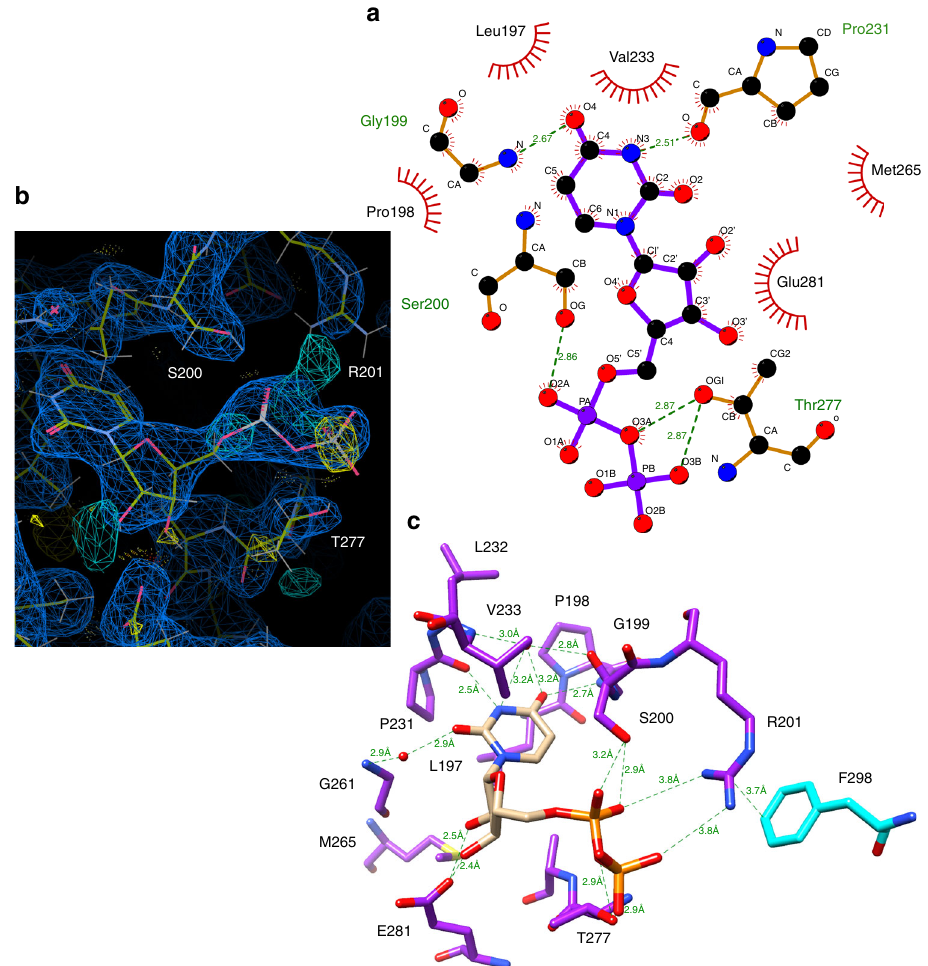
Fig. 3 LpxB nucleotide-binding pocket. The uracil of UDP binds in a hydrophobic pocket formed by L197, P198, P231, and V233. Putative hydrogen-bond distances in angstroms are as follows: G199 N to uracil O4 (2.7), G199 O to water to uracil O4 (2.8, 3.2), V233 N to water to uracil O4 (3.0, 3.2), P231 O to uracil N3 (2.5), G261 N to water to uracil O2 (2.9, 2.9), E281 O ε 2 to ribose O2' (2.5), E281 O ε 2 to ribose O3' (2.4), S200 O γ to α -phosphate O1 (3.2), S200 O γ to α -phosphate O2 (2.9), T277 O γ to bridging pyrophosphate O (2.9), and T277 O γ to β -phosphate O2 (2.9). R201, which is critical for activity 10 , is interacting with the α -phosphate O2 and β -phosphate O1 at 3.8, via its η -nitrogens and appears to be positioned to stabilize the UDP leaving-group. a Image generated in LigPlot+ 69 . b Image generated in Coot 62 , showing the electron density maps for UDP and the surrounding residues. The 2mFo-DFc map (blue mesh) is shown at 0.4317 e Å − 3 (0.99 r.m.s.d.), and the mFo-DFc map (cyan mesh for positive and yellow mesh for negative) is shown at 0.45e Å −